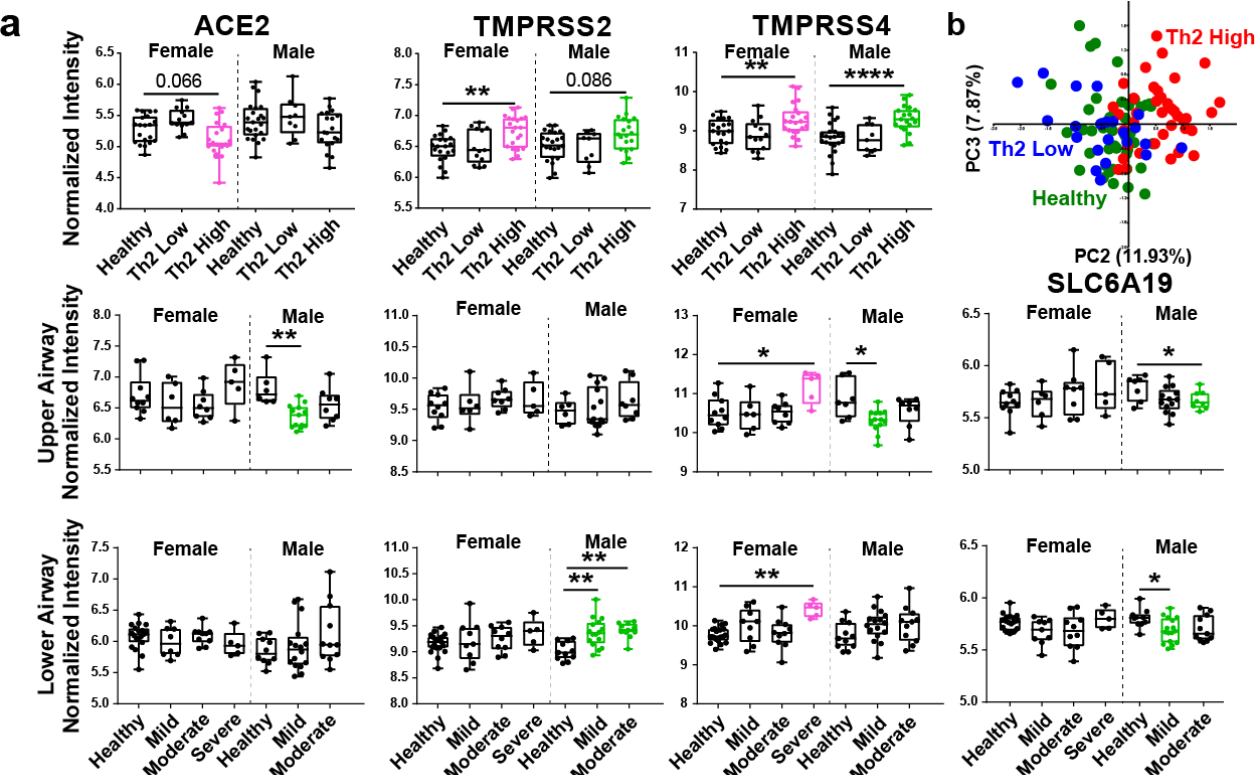
Figure 1. SARS-CoV-2 genes are dysregulated specifically in Th2 high asthma and are different by sex and airway location. ( a ) Box and whisker plots showing normalized intensity values of COVID-19 related genes in healthy and asthmatic samples broken down by sex. Top row compares healthy ( n = 20 Female, 23 Male), Th2 low ( n = 13 F, 9 M), and Th2 high ( n = 2 F, 19 M) asthma. Middle row compares healthy (n = 10 F, 7 M), mild (n = 6 F, 13 M), moderate (n = 8 F, 8 M), and severe ( n = 5 F) asthma in the upper airway. Bottom row compares healthy (n = 19 F, 11 M), mild ( n = 9 F, 16 M), moderate ( n = 10 F, 11 M), and severe ( n = 5 F) asthma in the lower airway. ( b ) PCA plot summarizes variation in virus entry genes and associated viral immunity genes (ANPEP, DPP4, CTSL, CTSB, ST3GAL4, ST6GAL1, IRAK3, IDO1, NOS2, OAS1, MX1, TNFSF10). Statistical significance was calculated using ANOVA with Tukey post-hoc analysis. In box and whisker plots, all data points are shown and the box represents the second and third quartiles and median. * p < 0.5, ** p < 0.01, **** p < 0.0001.